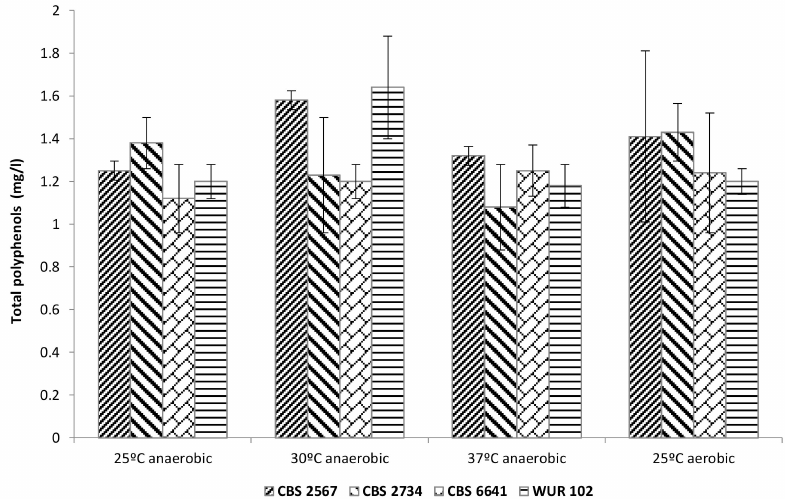
Figure 6. Total polyphenol content in fermented cashew apple juice employing the selected